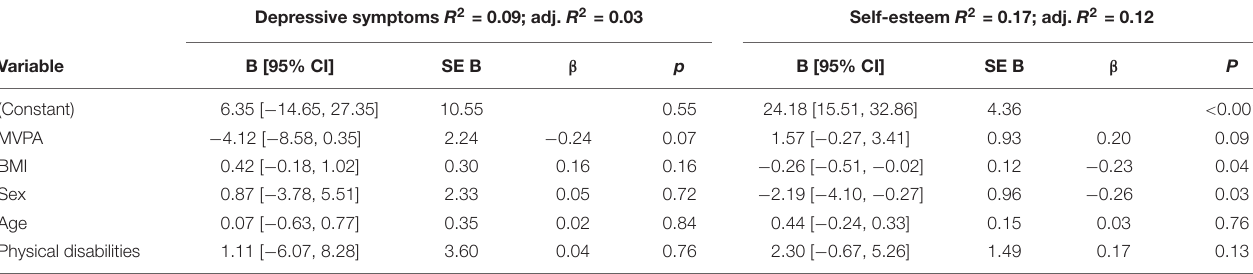
TABLE 3 | Regression analyses of MVPA on depressive symptoms and self-esteem. Depressive symptoms R 2 = 0.09; adj. R 2 =